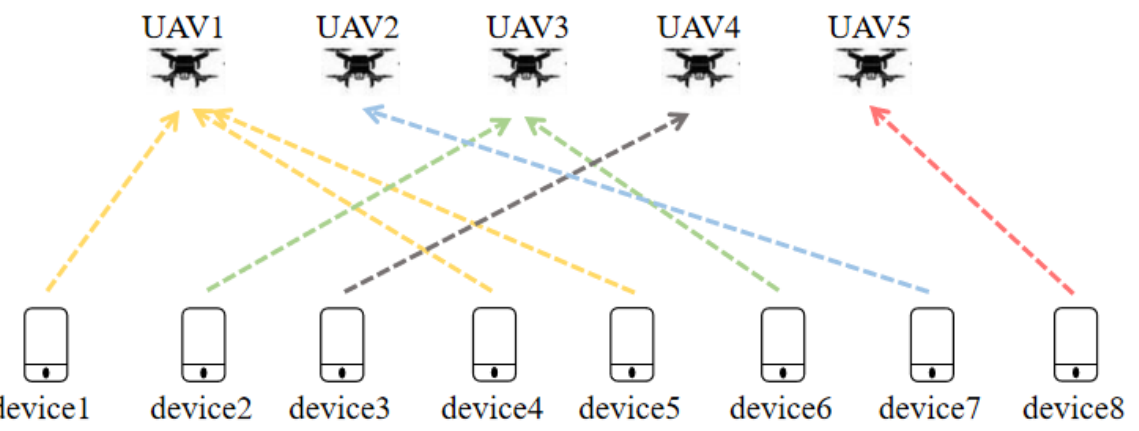
Figure 4. Illustration of the solution x = {1, 3, 4, 1, 1, 3, 2, 5}.